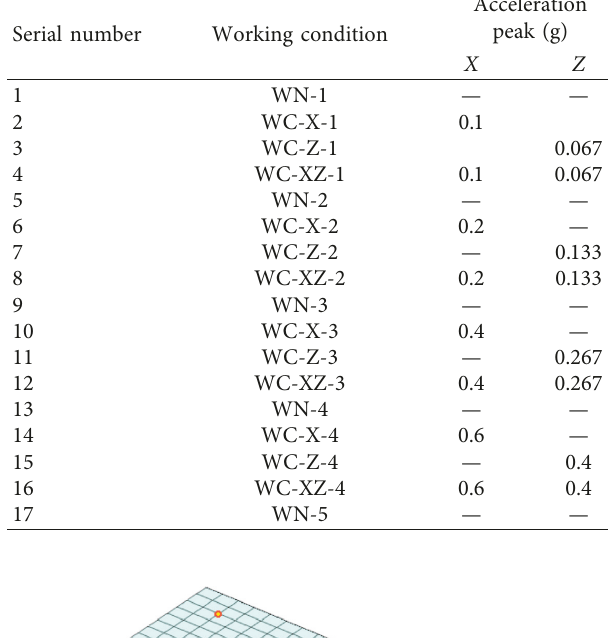
Table 1: Loading rule of shaking table test.